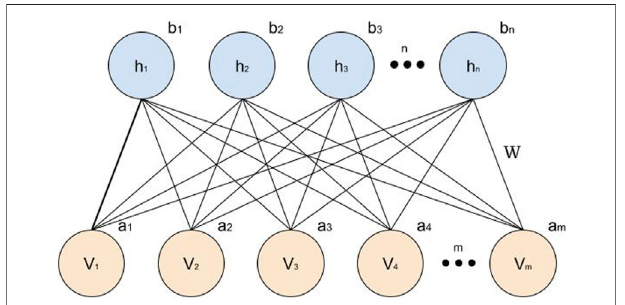
FIGURE 4 | A simple Restricted Boltzmann Machine